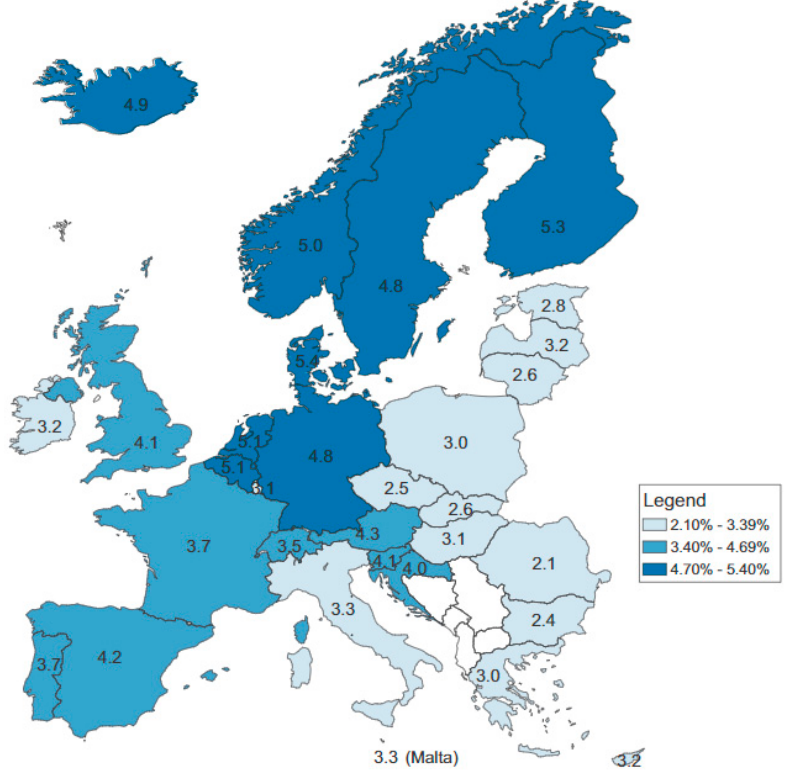
Figure 1. Estimated direct and indirect costs related to mental health problems across EU countries (as a % of GDP). Source: OECD estimates [7].